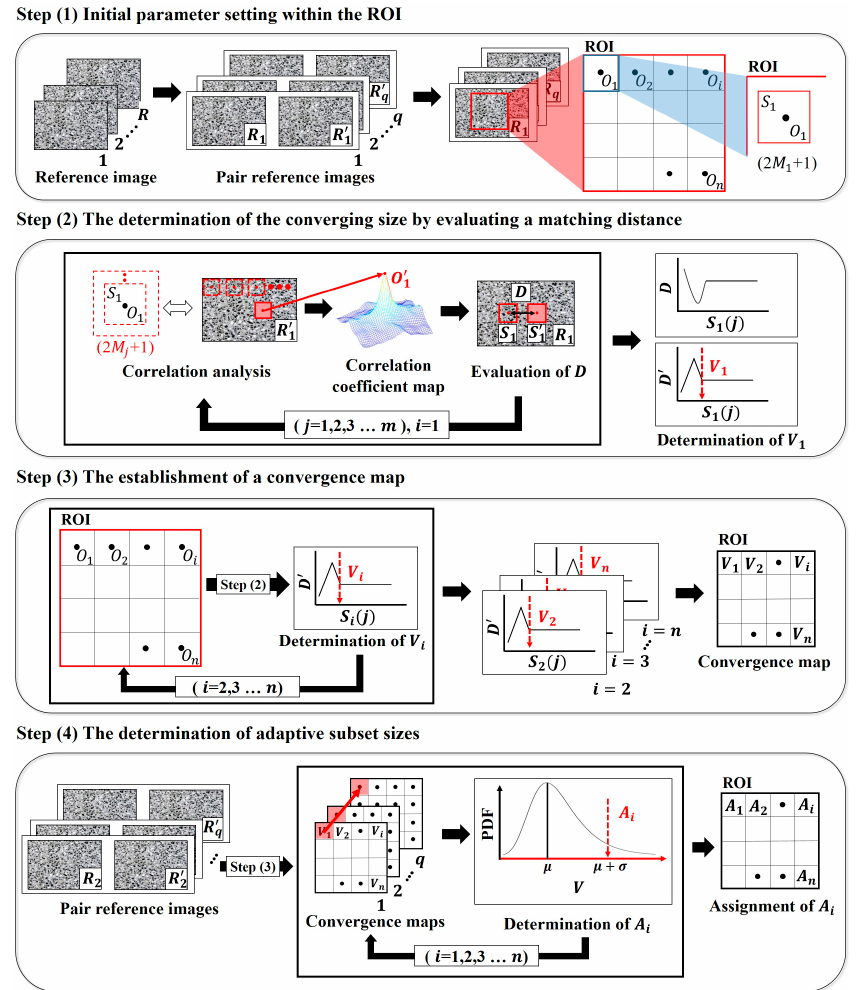
Figure 1. Overview of the automated size determination algorithm of adaptive subsets: R q and R (cid:48) q are the pair reference images. O i is the seed point on R q , and S i is the reference subset centered at O i . M j is the size parameter of S i , and S i ( j ) is O (cid:48) . D is the matching distance between S i and S (cid:48) i and A i is the adaptive subset size. PDF is the probability density